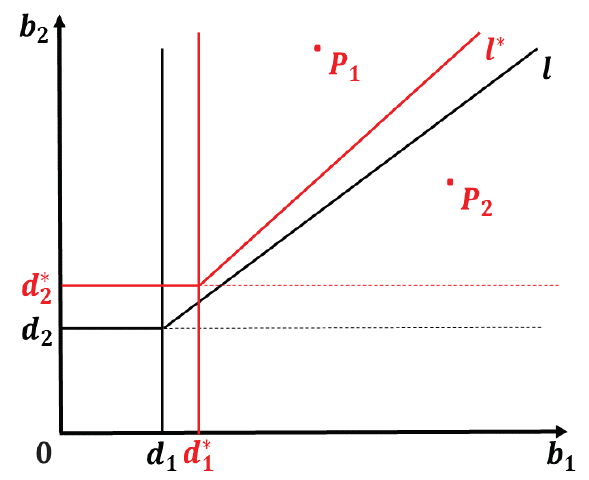
Figure 2. Comparison of the stability region for the spatially implicit model according to the average dispersal success approximation (red) and the non-spatial model (black) as in Figure 1. Analogously, ( b 2 − 1 ) = 1 ( b 1 − 1 ) is a transcritical bifurcation line that l ∗ satisfying b 1 > d ∗ , b 2 > d ∗ and 1 2 1 α β d ∗ 2 d ∗ 1 separates the region where the two points P 1 and P 2 are